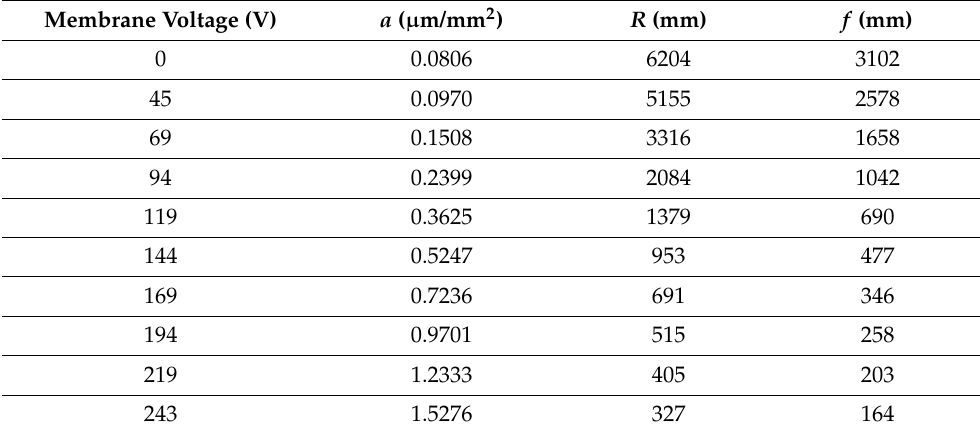
Table 2. MAAM parameters, obtained from surface measurements (see Figure 5) and converted into optical parameters as inputs for optical simulations.